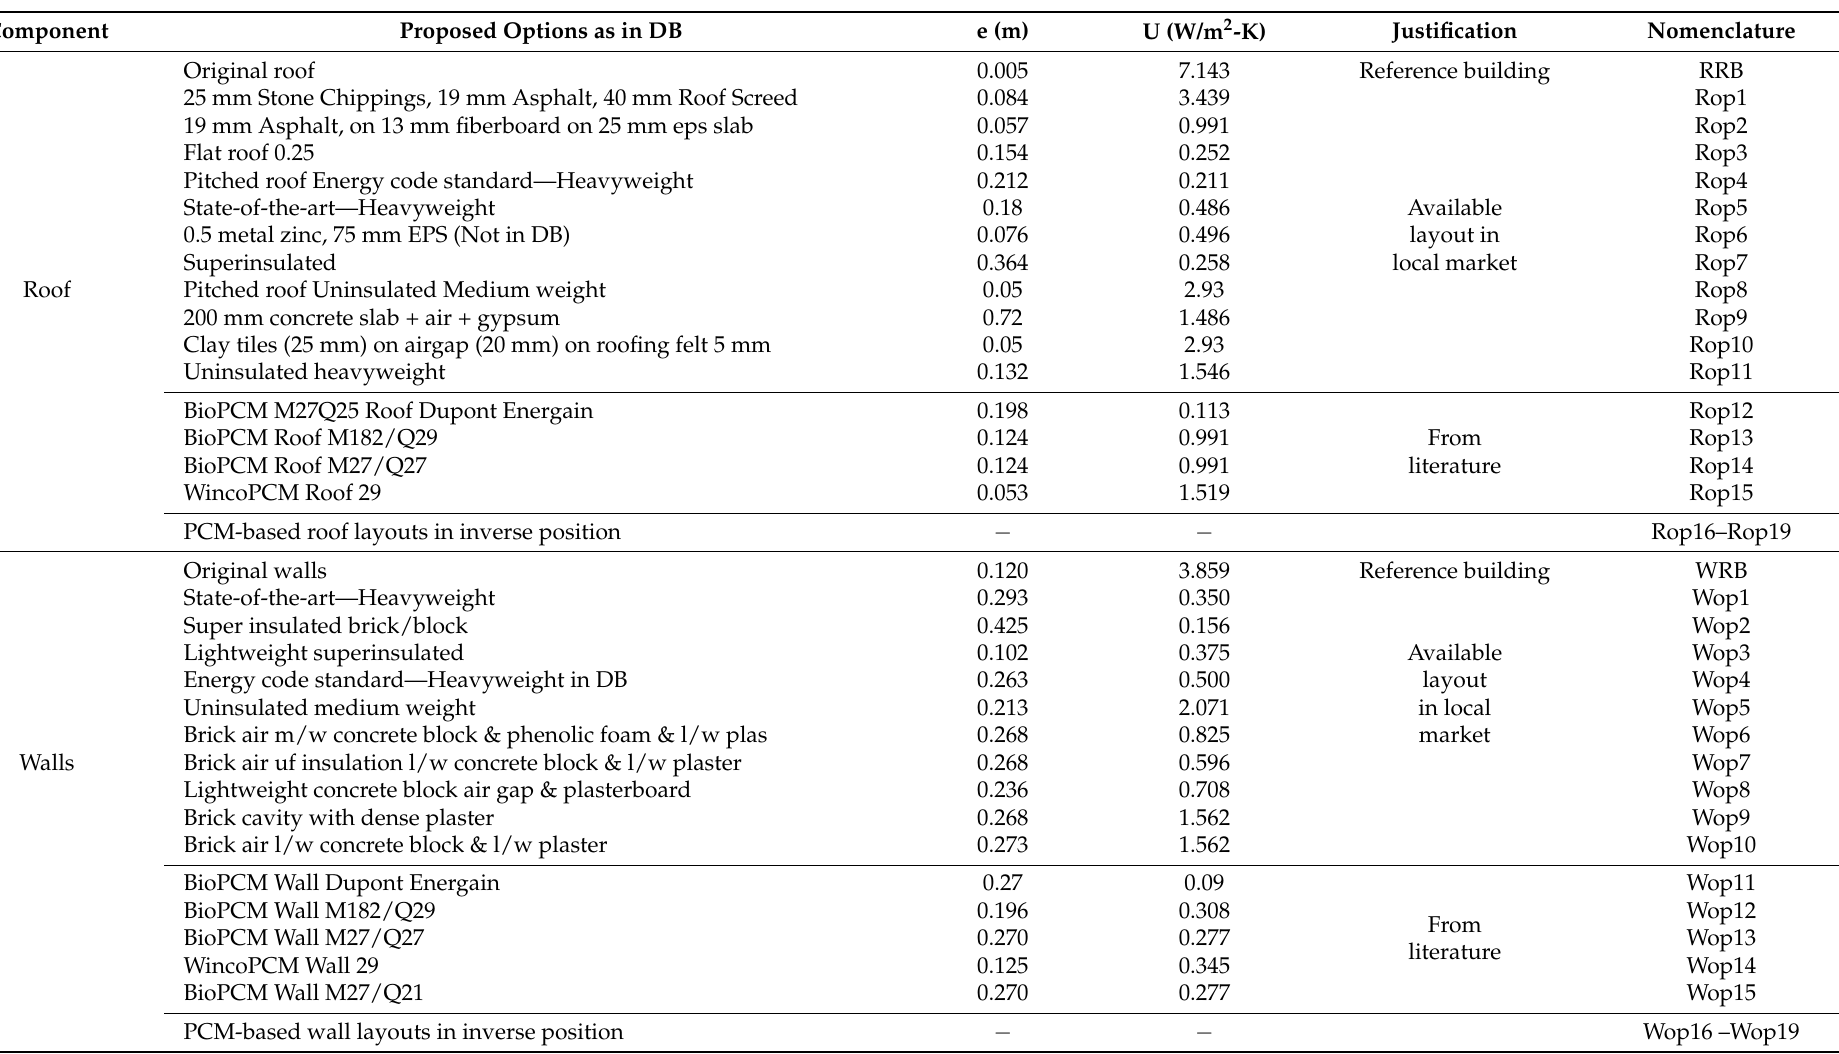
Table 4. Summary of the envelope layouts